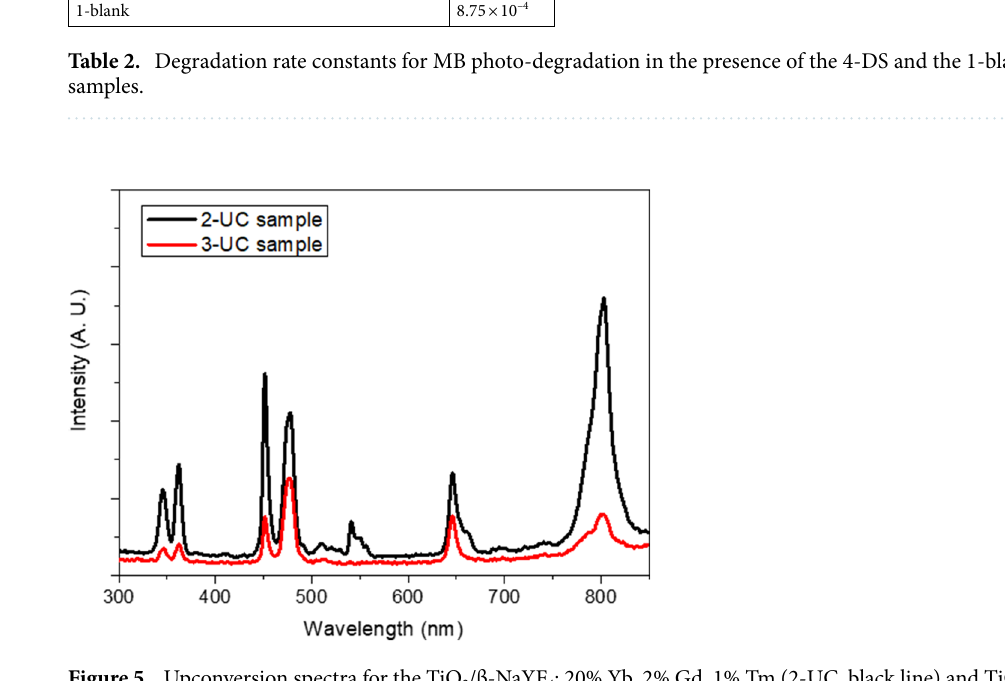
Figure 5. Upconversion spectra for the TiO 2 /β-NaYF 4 : 20% Yb, 2% Gd, 1% Tm (2-UC, black line) and TiO 2 /β-